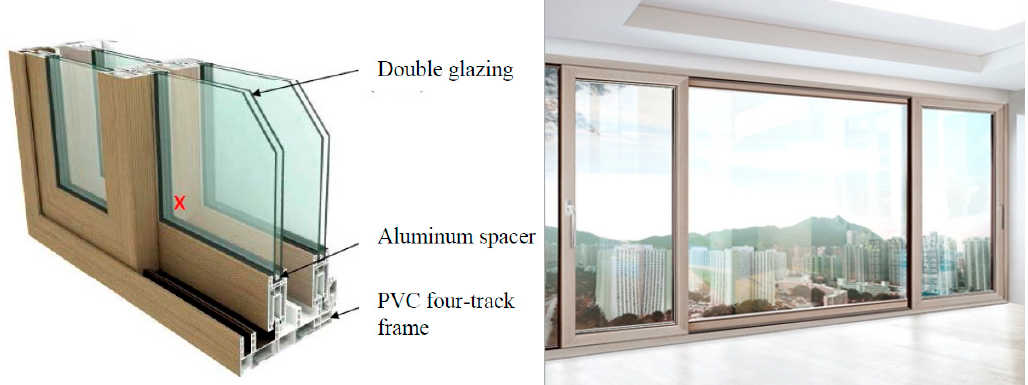
Figure 2. Double-glazed four-track horizontal sliding window and window installation in an apartment unit.